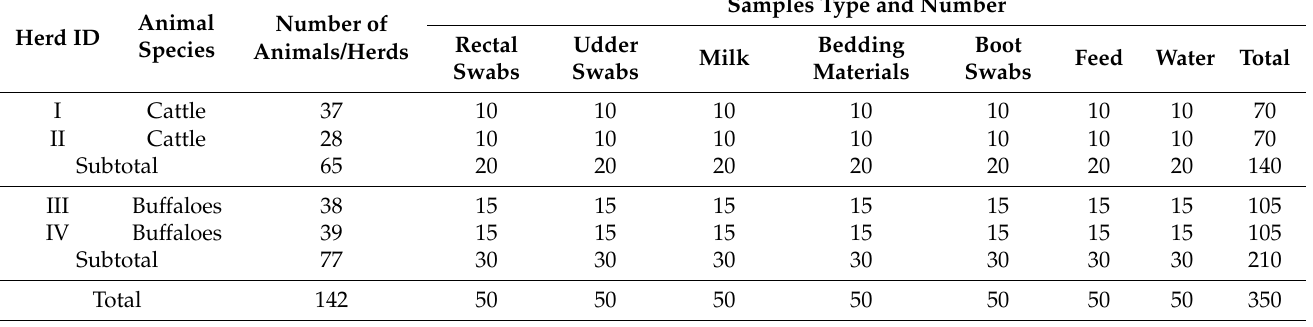
Table 7. Distribution of samples collected from different animal species, environments, milk, and Karish